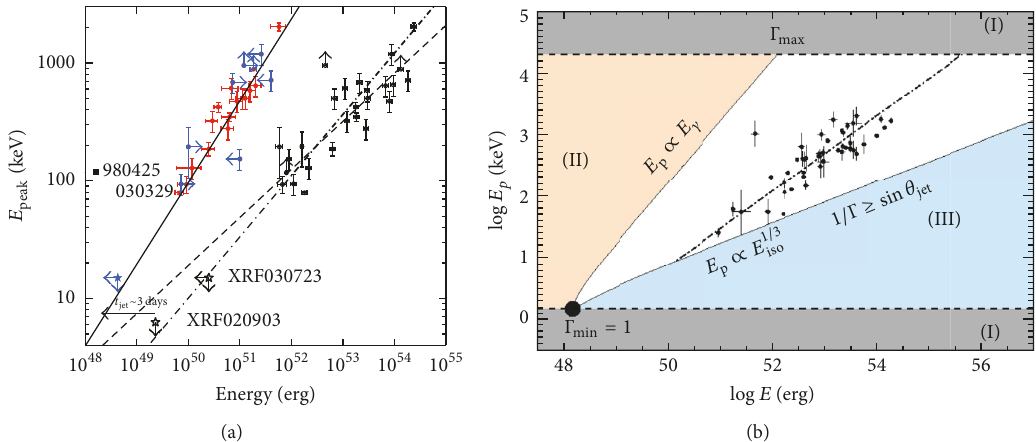
Figure 9: (a) 𝐸 ∗ - 𝐸 𝛾 relation for GRBs with known redshift. The filled circles represent 𝐸 𝛾 for the events where a jet break was detected. peak ∼ 53.68 + 0.7 log 𝐸 𝐸 Grey symbols indicate lower/upper limits. The solid line represents the best fit, that is, log 𝐸 𝛾 . Open circles denote peak iso for the GRBs. The dashed line represents the best fit to these points and the dash-dotted line is the relation shown by Amati et al. [111]. (Figure after Ghirlanda et al. [188]; see Figure 1 therein. @ AAS. Reproduced with permission.) (b) Rest frame plane of GRB energy. The large black = 1.5 keV and 𝐸 ∗ = 1.5 × 10 48 erg. Since Γ > 1 but less than 8000, regions (I) are dot indicates that all simulated GRBs were assigned 𝐸 ∗ 𝛾 peak ≤ 90 ∘ , they cannot stay in region (II). When Γ is small, the beaming cone turns out to be larger forbidden. Since for all the simulated GRBs 𝜃 jet = log 𝐸 + log (1+𝛽 )+2 log Γ , lower than the energy computed by than the jet. Therefore, the isotropic-equivalent energy is given by log 𝐸 𝛾 0 iso = log 𝐸 − log (1 − cos 𝜃 ) . This brings in a constraint, log 𝐸 ∼ 1/3 × log 𝐸 log 𝐸 , and GRBs cannot lie to the right of this constraint. 𝛾 iso jet peak iso Hence, region (III) is not allowed. The black dots indicate the actual GRBs of the Swift sample. The fit to the Swift sample is displayed as the dot-dashed line. (Figure after Ghirlanda et al. [209]; see Figure 1